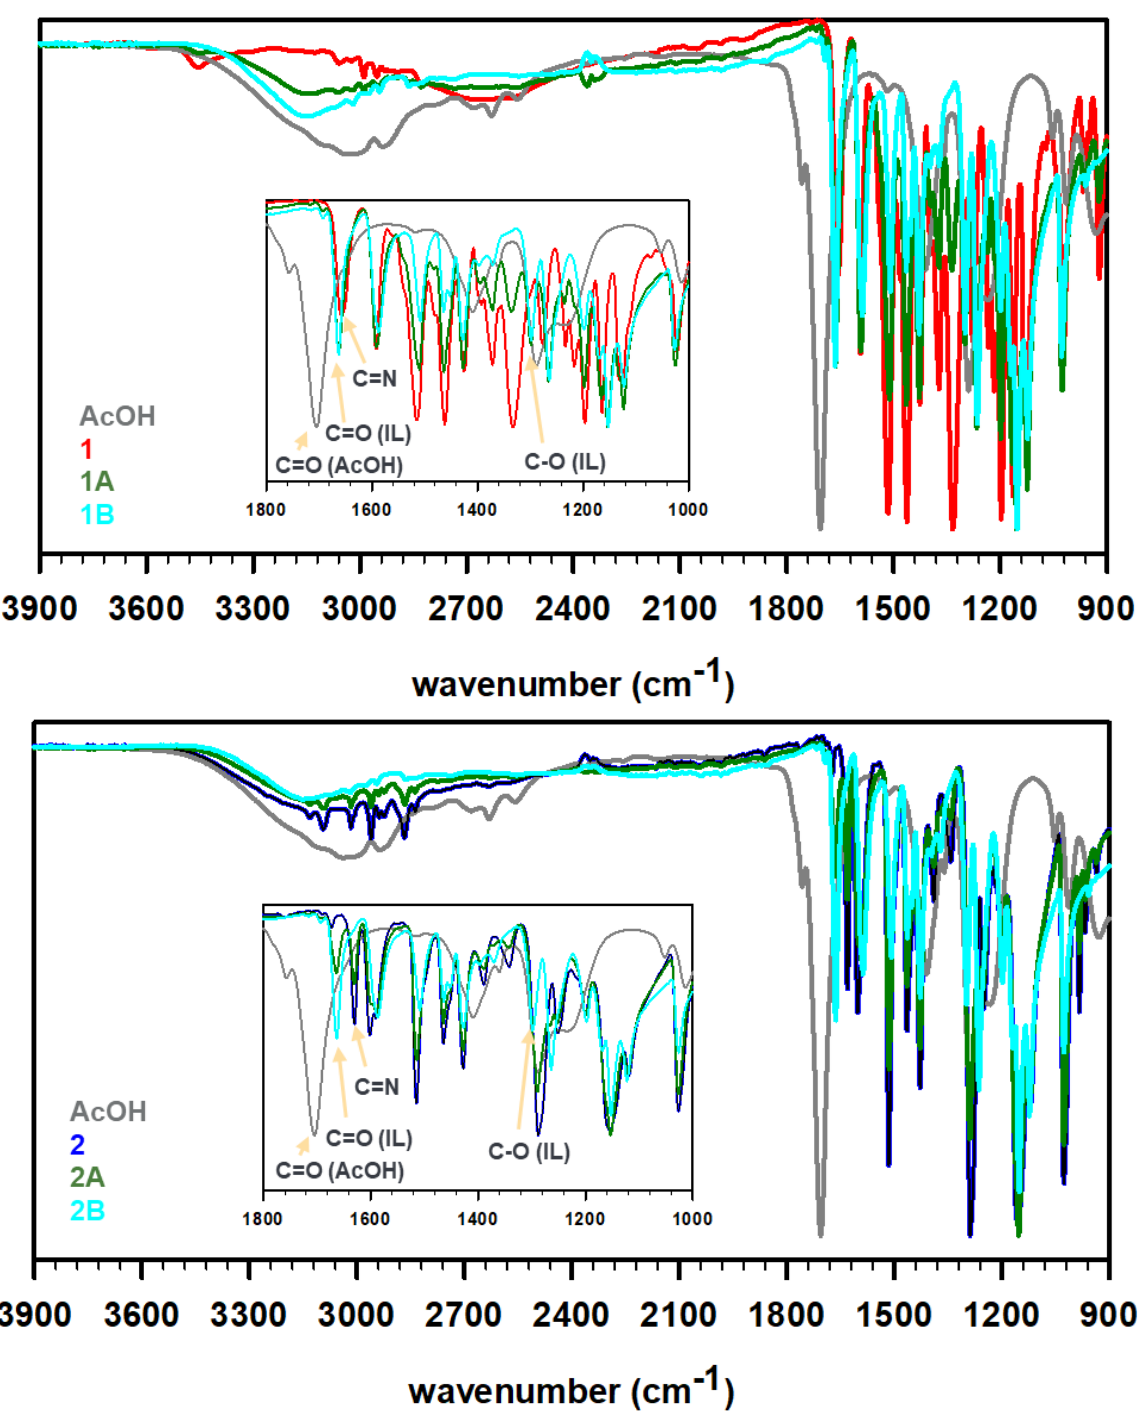
Figure 2. FT-IR profiles of acetic acid (dark gray), as-synthesized Schiff base 1 (red) or 2 (blue), 1:1 acetate IL 1A or 2A (olive), and 1:2 acetate IL 1B or 2B (cyan). The differential scanning calorimetry (DSC) profiles of these ILs revealed the prefer- ential proton occupancy sites in 1:1 and 1:2 acetate derivatives of 1 and 2 (Figure 3). The high melting characteristics of imines were also observed in 1:1 acetate derivatives of these imines in the case of 2A . This indicates that 1:1 salt was not formed, instead, both nitrogen atoms in the imines seemed to be fully protonated in the presence of acetic acid. When one equivalent of acetic acid was added, only 50% of the imine was fully protonated,